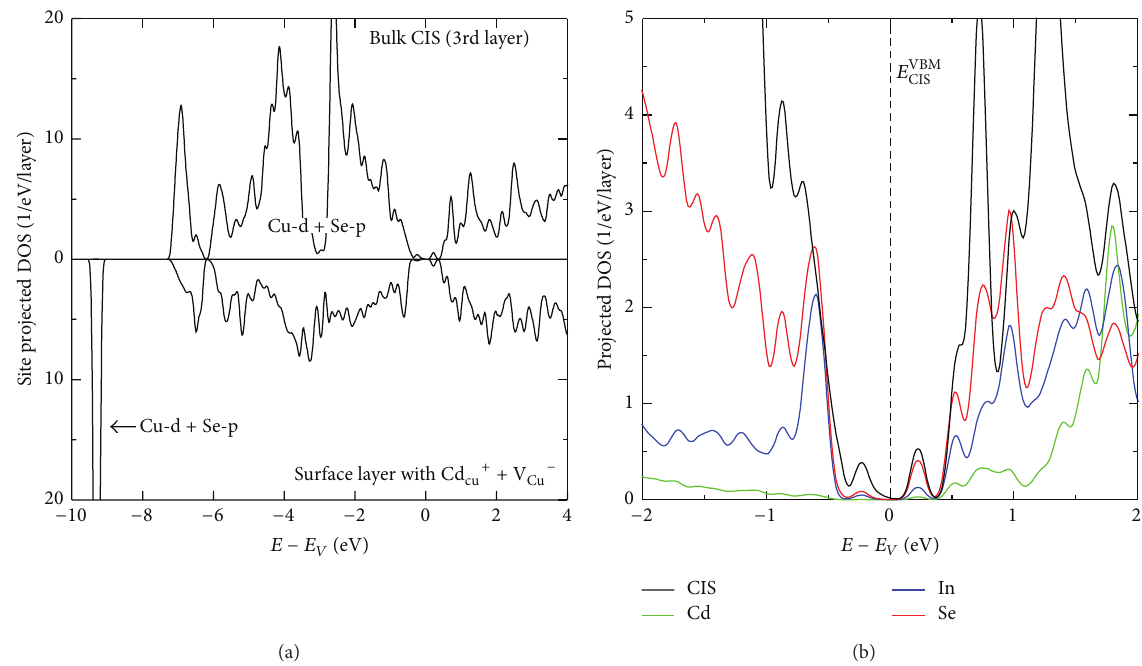
+ + V − (the lower panel) and the third Cu Cu